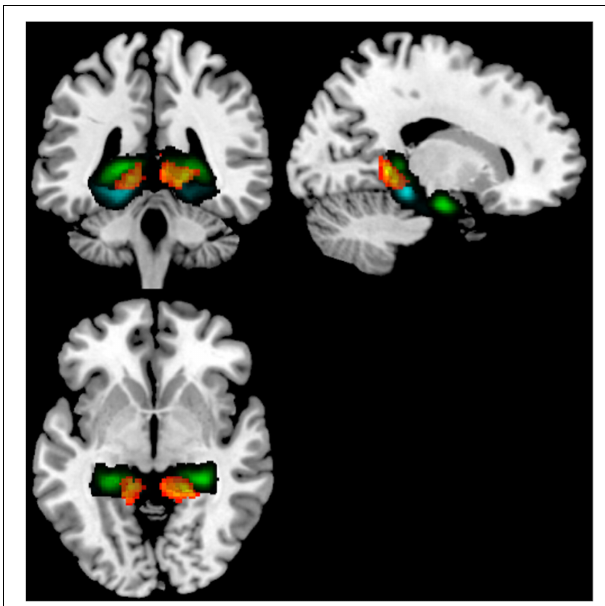
FIGURE 3 | Seed-to-voxel analysis contrasting older users vs older non-users, illustrating increased rsFC from a cerebellum 4/5 seed to a cluster (warm colors) overlapping the hippocampus (green) and posterior parahippocampal cortex (cyan). Target regions derived from the Harvard-Oxford atlas. Illustrated slices from X = 184, Y = 135, Z = 132.